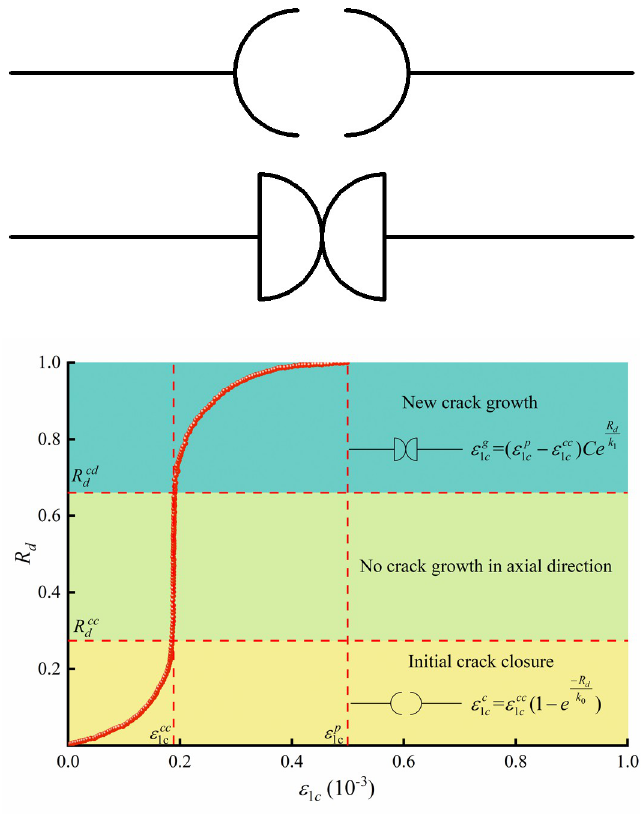
Fig 11. Rock crack evolution elements. (a) Initial crack closure element, (b) New crack growth element, (c) The role of axial crack strain elements.